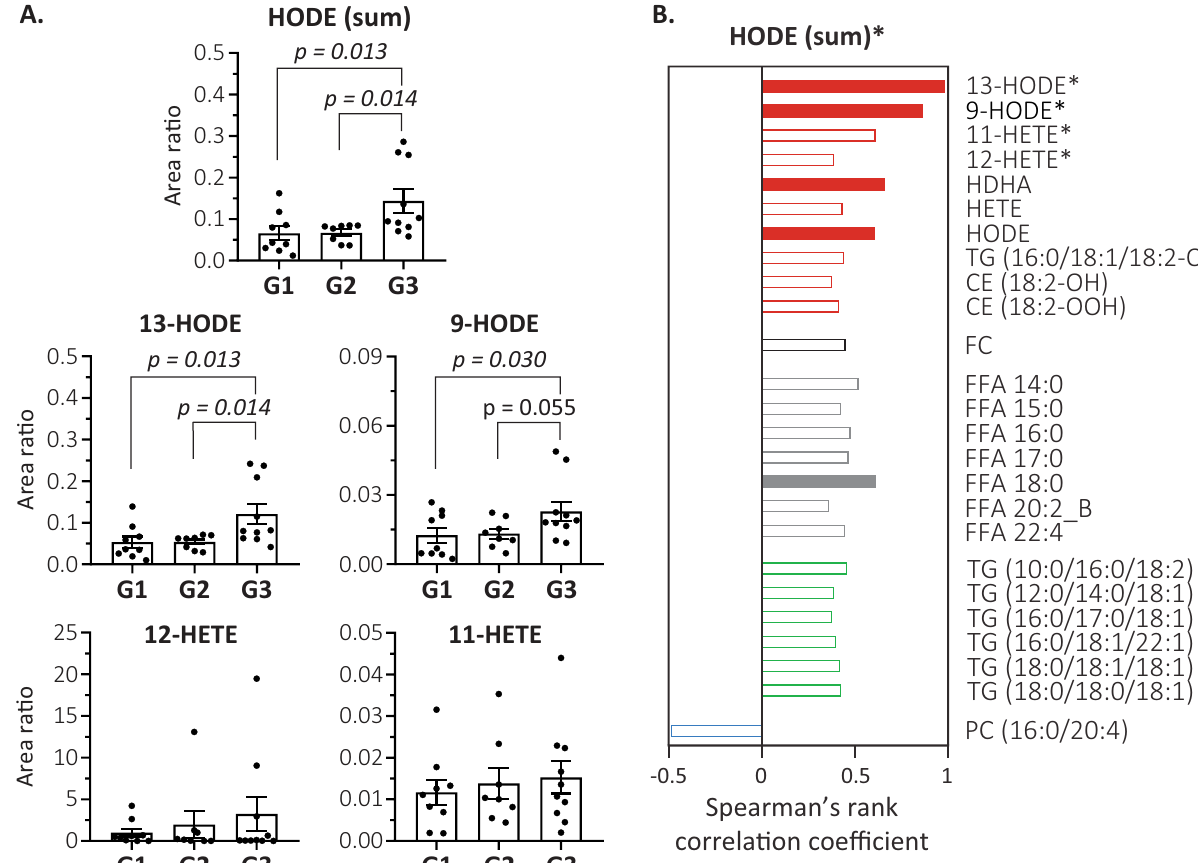
Fig 3. Relationship between plasma levels of hydroxyoctadecadienoic acid (HODE) and ZIKV-induced microcephaly. (A) Oxilipidomic analysis of HODE (see also S3 Fig) and hydroxyeicosatetraenoic acid (HETE) isomers (modified from [48]; S2 Methods). HODE (sum) represents summed concentrations of 9- and 13-HODE isomers. Concentrations are displayed as area ratio (bars indicate average ± standard error of the mean) and comparisons were determined by unpaired t-test (p < 0.05 shown in italics). (B) Significant association of HODE (sum) with lipid species (p < 0.001 filled bars; p < 0.05 empty bars) by Spearman’s rank correlation analysis. Bars are color coded for oxidized lipids (red), free cholesterol (black), FFA (gray), TG (green) and phospholipid (blue). Oxidized linoleic acid linked to TG and CE is represented by 18:2-OH or -OOH, where OH denotes monohydroxyl and OOH hydroperoxyl groups. � = lipids quantified by oxilipidomics; HDHA = hydroxydocosahexaenoic acid. Abbreviations for lipid classes are depicted in Table 1 or in the main text.